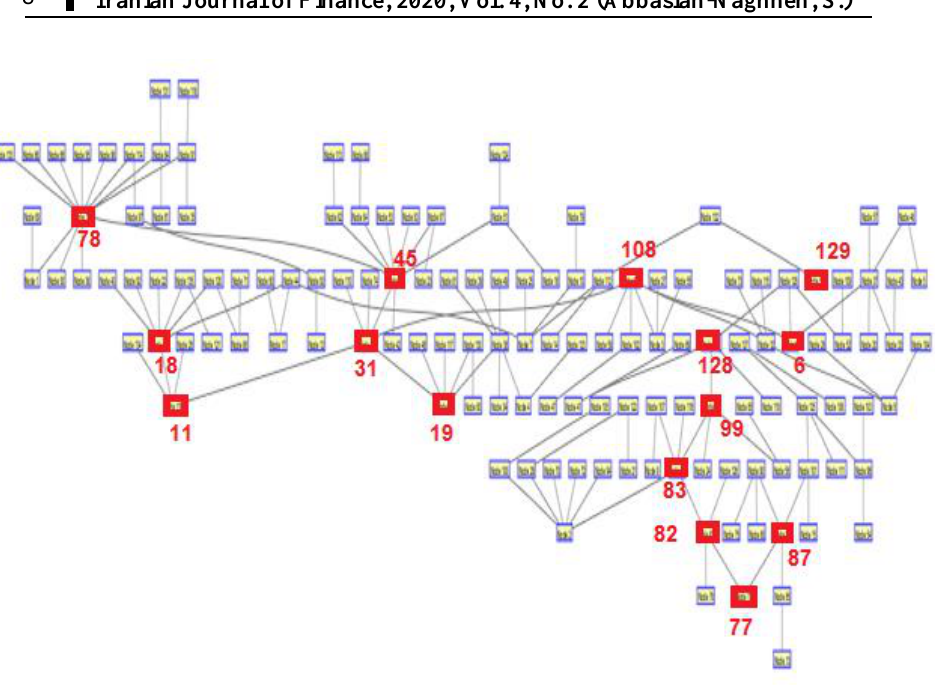
Figure 1. The minimum spanning tree of the examined network